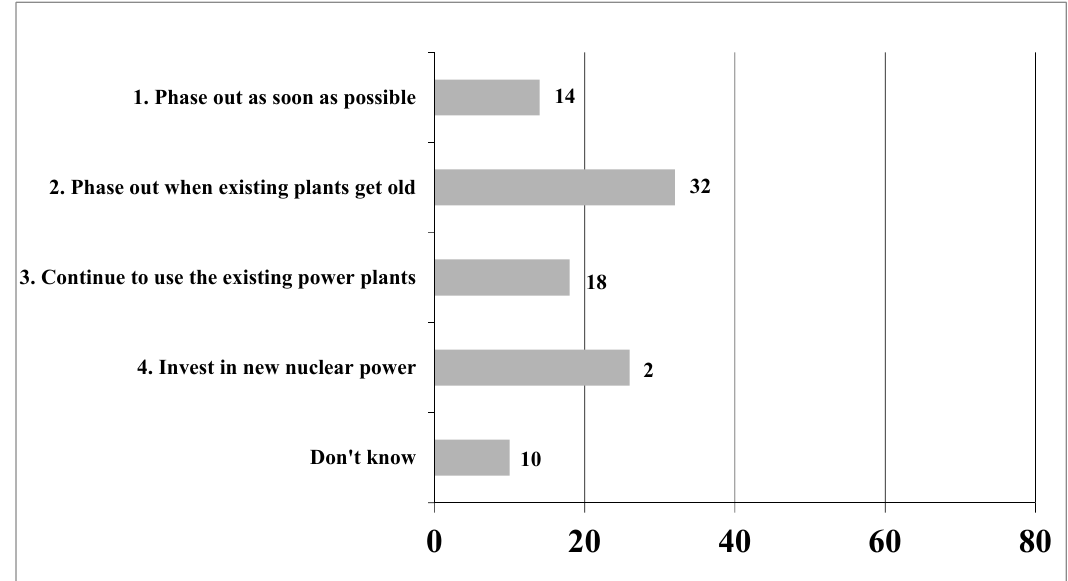
Figure 8. Question just to the citizens: If we today would have a referendum about future nuclear power, how would you vote?